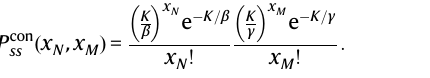
Fig. 1 | Framework for the rational design of transcriptomics experiments. a Model-based closed loop paradigm. A researcher begins by representing two or more competing hypotheses as interpretable and tractable mathematical models (middle right of circle). Next, they perform a detailed mathematical analysis of each model, computing quantities (e.g., RNA count distributions and moments) that can help distinguish one hypothesis from another. Using the results of that analysis as input, they identify the experiment that best distinguishes the two models.Finally,theyperformthisexperimentonsomepopulationofcells,usethe resulting data to re fi ne and/or reject models, and repeat the process with an updated ensemble of models. b Interpretable and tractable modeling framework for transcription rate variation. We consider stochastic models of transcription involving (i) nascent/unspliced RNA, (ii) mature/spliced RNA, and (iii) a stochastic